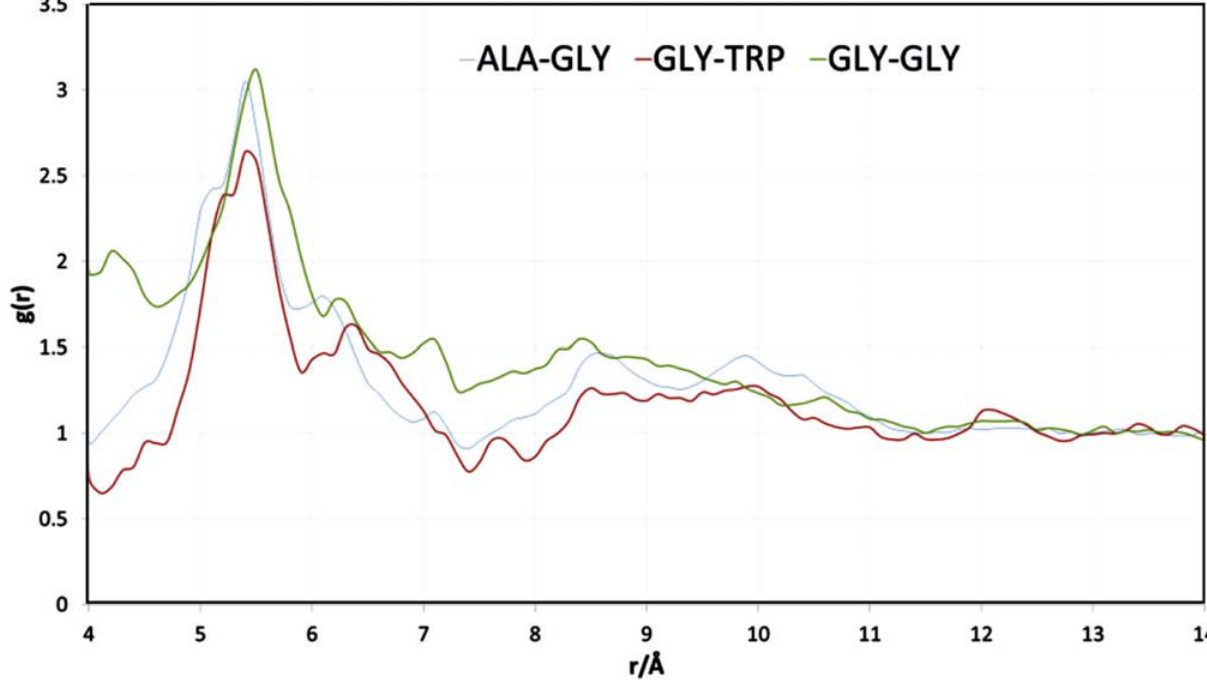
Figure 4 . Radial distribution functions for pairs alanine-glycine, glycine-tryptophane, and glycine-glycine.